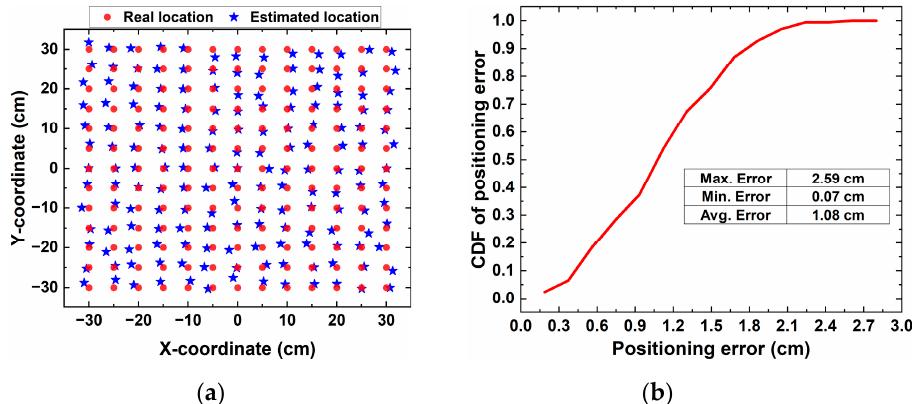
Figure 12. Distribution ETD of ( a ) LED 1, ( b ) LED 2, ( c ) LED 3, and ( d ) LED 4.